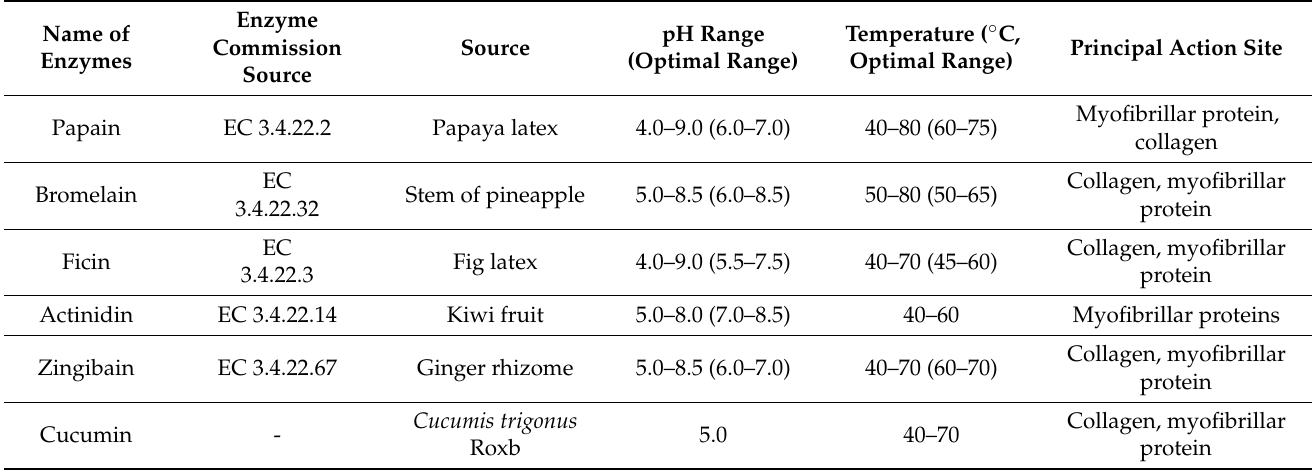
Table 1. Physiological attributes of some common plant